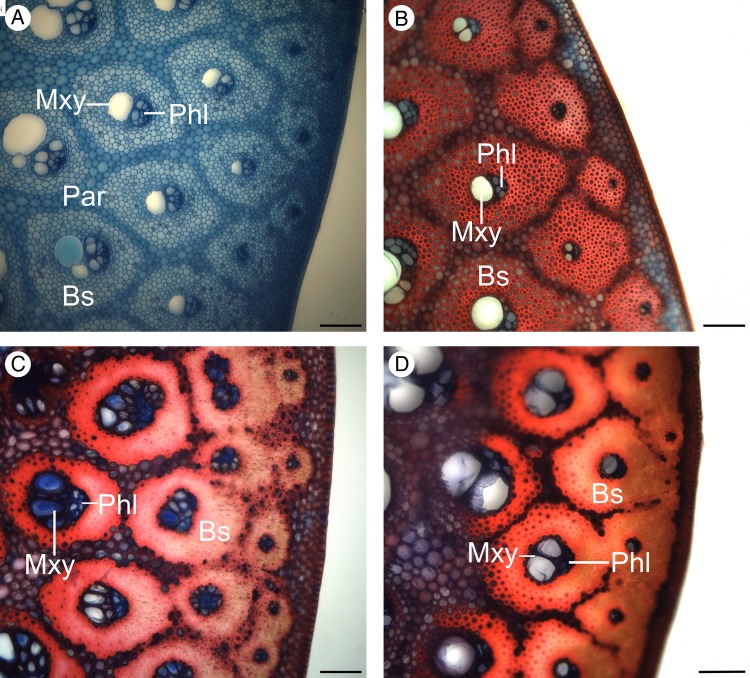
Details of developmental changes in transverse sections of the peripheral region of the stem, with increased maturity from A to D. (A) Young apical stem sections hardly show any lignification. Furthermore, vascular bundles are still separated by parenchyma. (B) Onset of lignification and increase of tissue density; bundle sheaths are still not fused. (C) Fusion of bundle sheaths and lignification of parenchyma increases. (D) In older, rigid and basal stems, maximal bundle sheath fusion and tissue density are observed. Par, parenchyma; Phl, phloem; Bs, bundle sheath; Mxy, metaxylem. Scale bars are 100 µm.